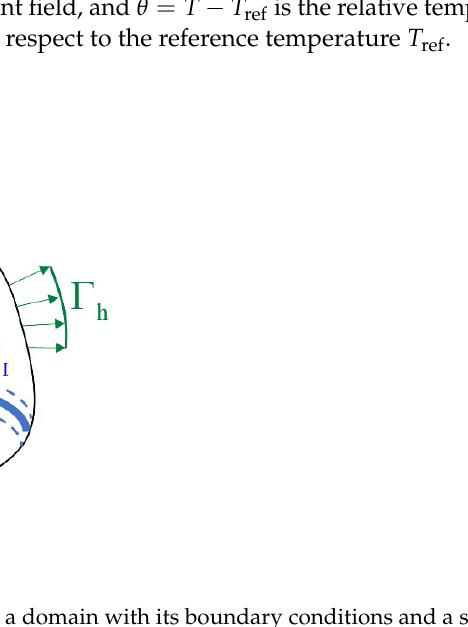
Figure 1. Schematic representation of a domain with its boundary conditions and a strong disconti- nuity at Γ I